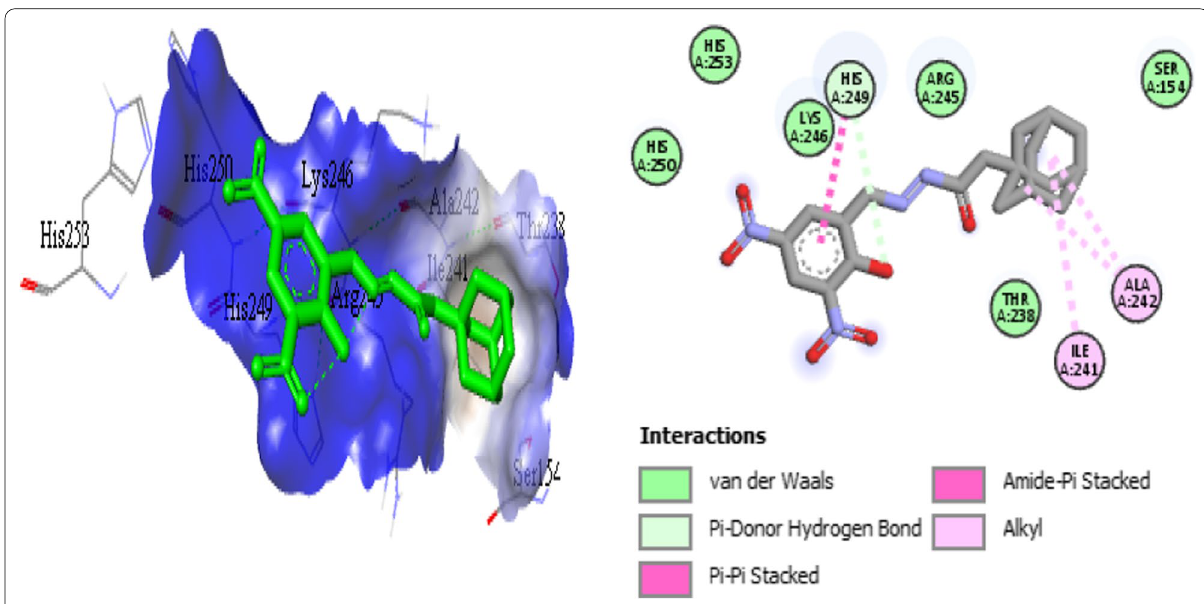
Fig. 2 Interaction of compound 44 with the crystal structure of IncA soluble domain